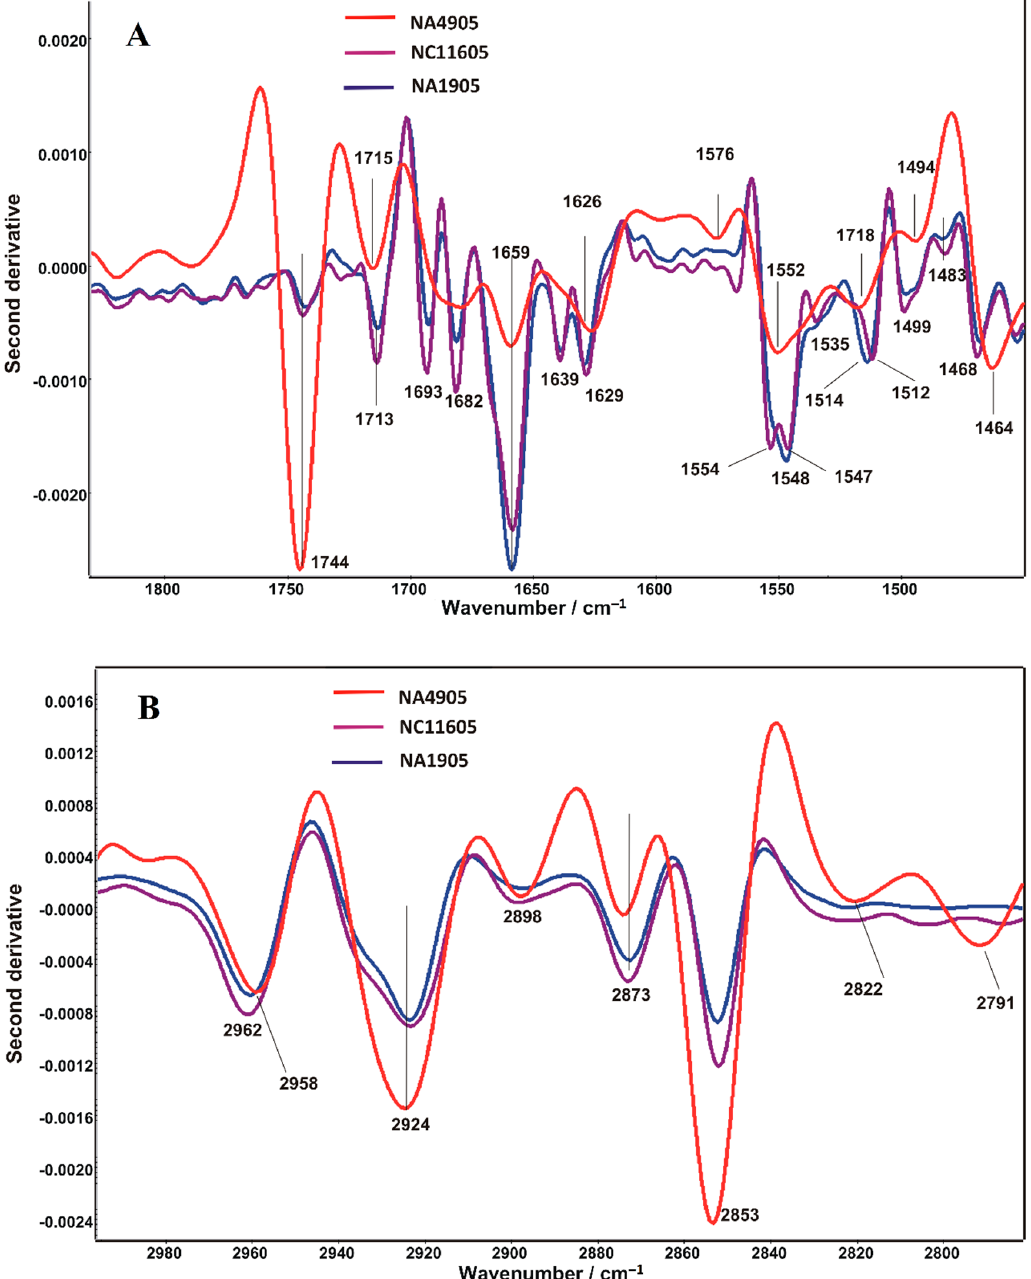
Figure 4. Savitzky–Golay’s second derivative FT-IR spectra in the range from 1800–1450 cm − 1 ( A ) and 3200–2800 cm − 1 ( B